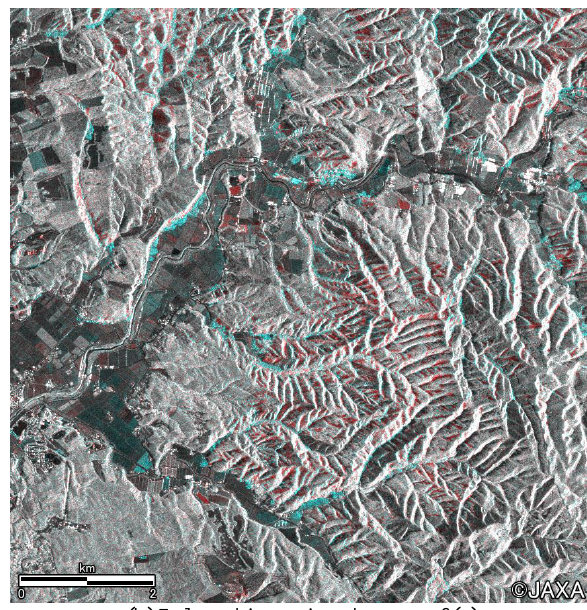
Figure 8. The expected landslides (colored by red) and debris areas (colored by cyan) in eastern Hokkaido, Japan estimated by PALSAR-2 images acquired after (Sep. 6, 2018) and before (Aug. 23, 2018) the